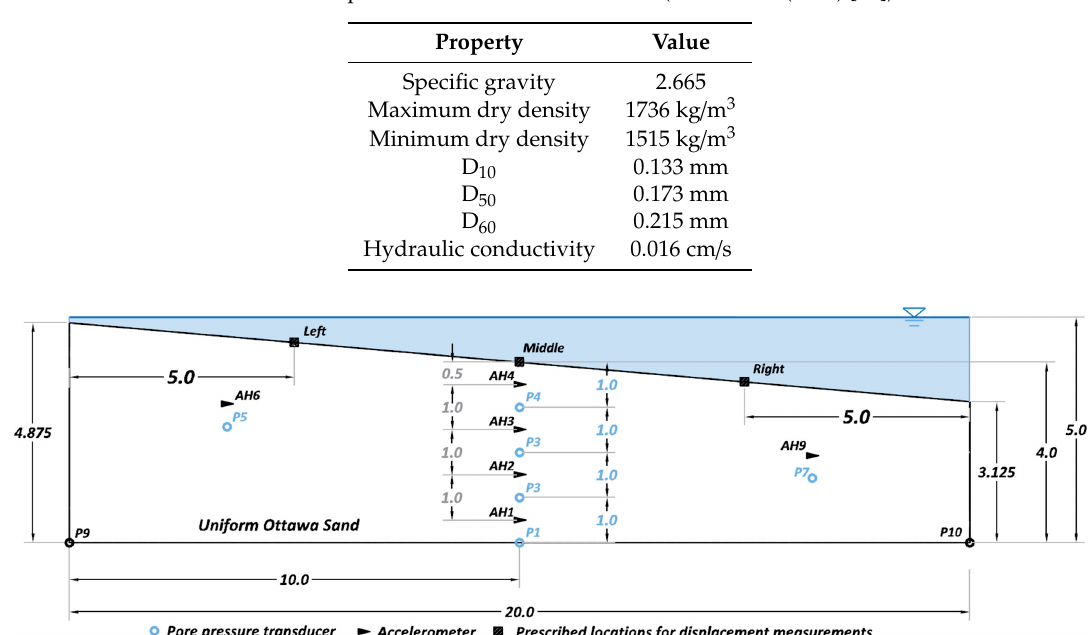
et al. (2018) [33]). In this test, the soil layer was 4 m high at the center of the model (prototype